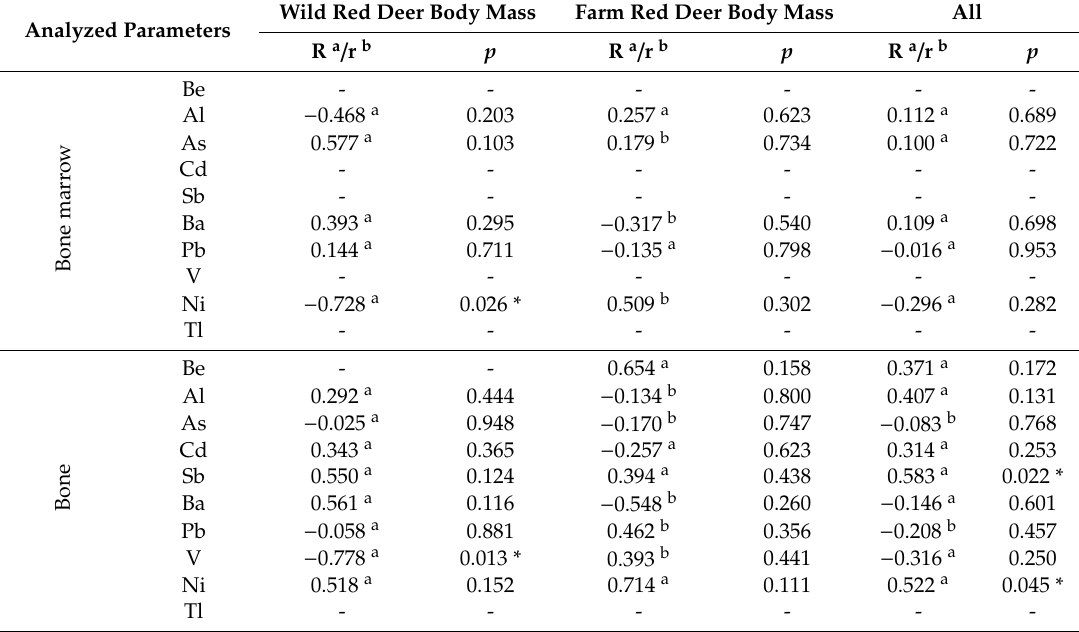
Table 3. Comparison of the concentrations of TE in the bone marrow and bones with the body weight of the wild and farmed red